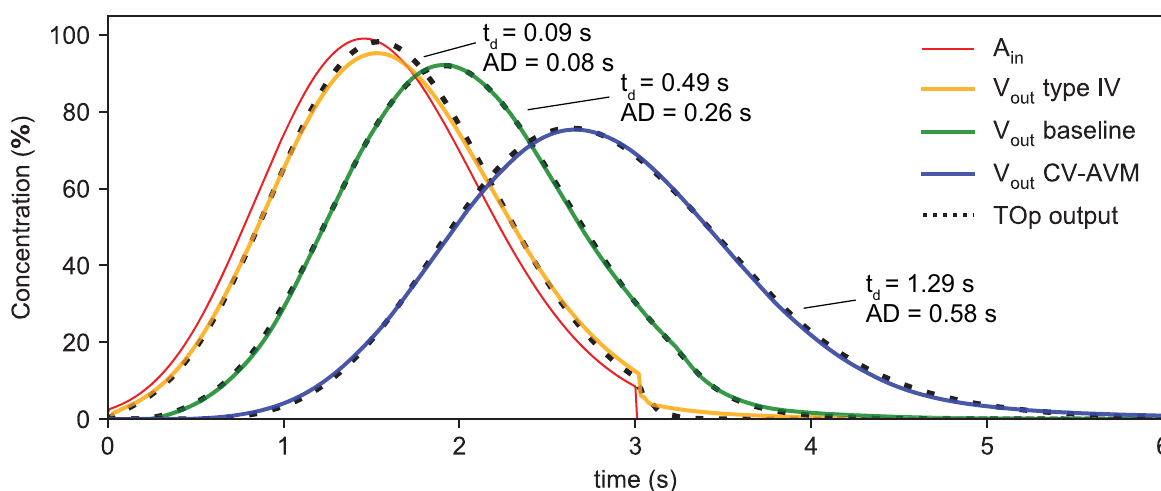
Fig 5. CA concentration at inlet and outlet nodes of computational AVM models. Temporal evolution of CA concentration at the injection point A in (red curve) and at the venular outlet node V out of computational prototypes for baseline conditions (green), type IV (orange) and CV (blue) AVMs. The dashed black lines represent the output of the fitted TOp for each configuration.